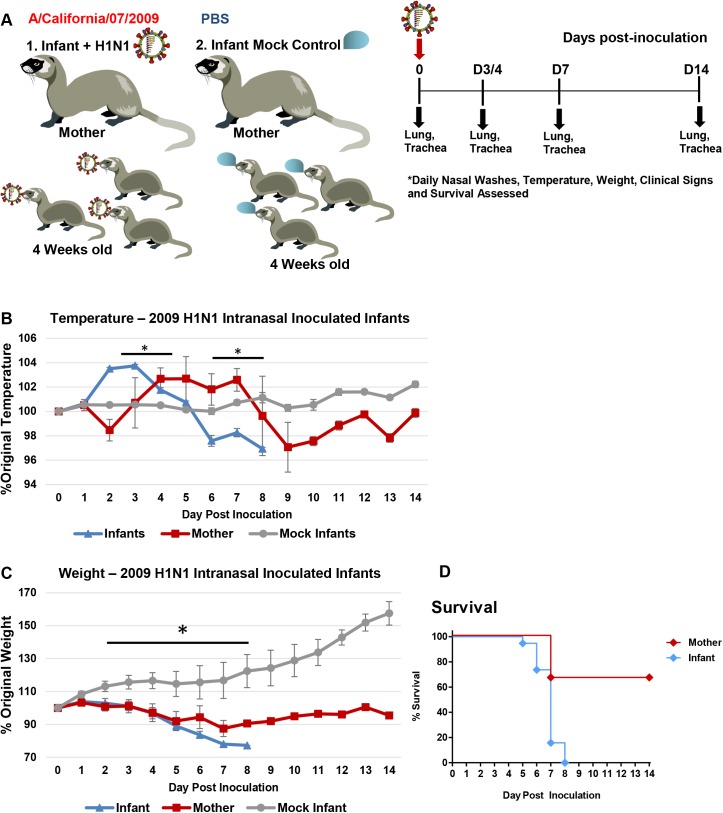
Intranasal 2009 H1N1 infection in infant ferrets leads to severe disease and mortality in both mother and infant ferrets.Schematic of experimental design for mother-infant dyad inoculations (A). Infants were intranasally inoculated with the A/Cal strain of 2009 H1N1 influenza (105 EID50) and housed with their nursing-mothers. Temperature (B) and weight (C) were recorded for 14 days post-infant-inoculation. Control mock inoculated infants (grey lines) were used to assess natural fluctuations in growing infants. Survival of mothers and infants was determined over 14 days (D). Results show the mean or are representative of 3 independent litter inoculations/infections (3 mother ferrets and 19 infant ferrets) and 3 litter mock inoculations (3 mother ferrets and 11 infant ferrets). * indicates a p-value less than 0.05 determined by ANOVA comparing 2009 H1N1 inoculated/infected to mock controls. Error bars indicate +/- SE.